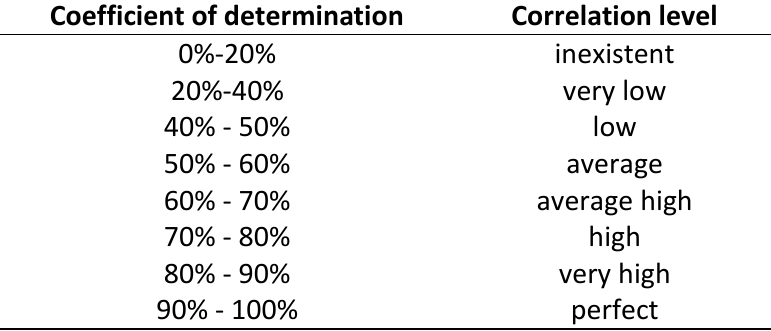
Table 3. Correlation level